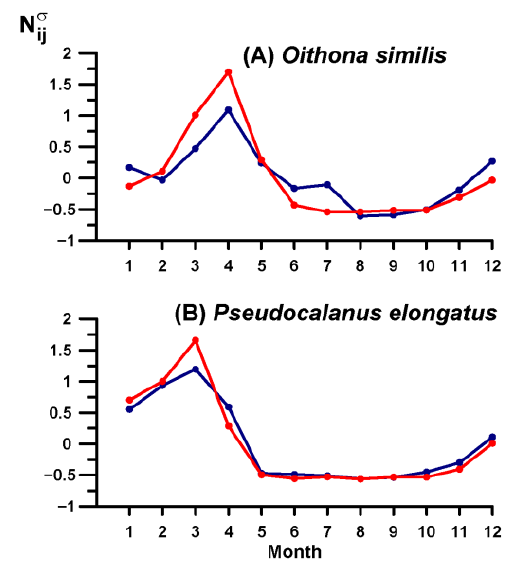
Figure 5. The patterns of seasonal dynamics of cold-water crustaceans in Sevastopol Bay at station 1 (blue) and station 2 (red) presented as normalized average monthly values (see details of the method in Section 2.4): ( A ) — Oithona similis ; ( B ) — Pseudocalanus elongatus .